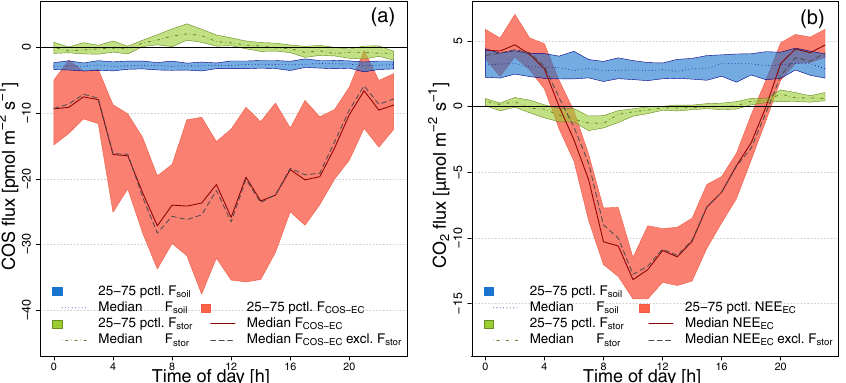
Figure 2. Storage fluxes F stor (green), ecosystem fluxes NEE EC and F COS-EC (red) and soil fluxes F soil (blue) of COS (a) and CO 2 (b) in summer (July and August) 2015. Thick lines indicate the median values of the data over the whole measurement period, and the shaded areas specify the 25th–75th percentiles. The median values of NEE EC and F COS-EC without storage correction are shown in gray. The ecosystem fluxes are filtered for low u ∗ values with a threshold of 0.3ms − 1